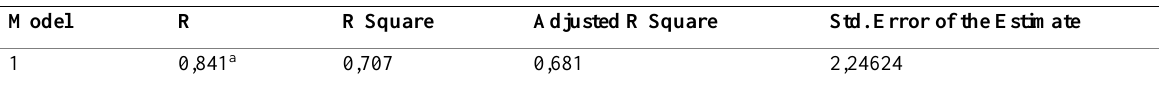
Table 1: Determination Coefficient Test (R 2